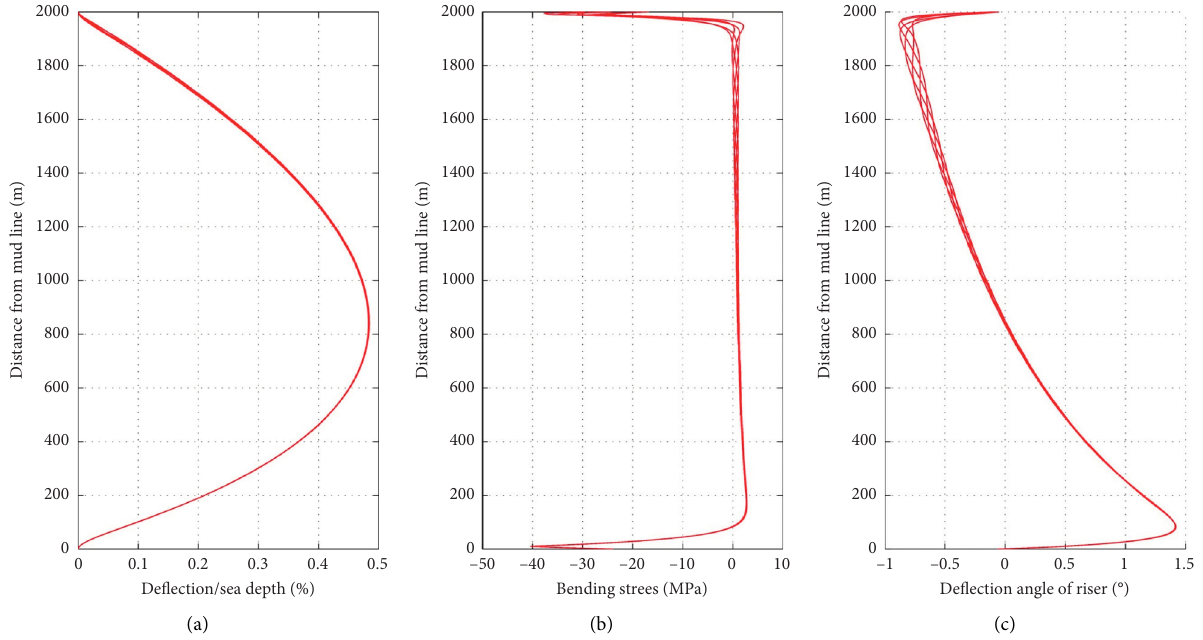
Figure 5: Dynamic responses for a riser with 2000m in its dynamic stable condition, (a) distribution of lateral deflection, (b) distribution of bending stress, and (c) distribution of deflection angle of the riser.